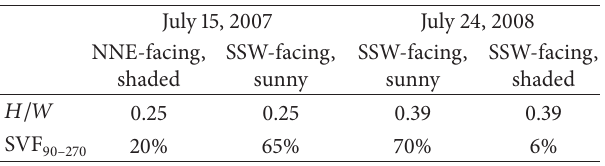
Table 1: Aspect ratio 𝐻 / 𝑊 ( 𝐻 :building height, 𝑊 : street width) and (sky view factor related to the southern half of the upper SVF 90–270 hemisphere) at the measuring sites within the WNW street canyon in Freiburg, “Vauban” quarter.